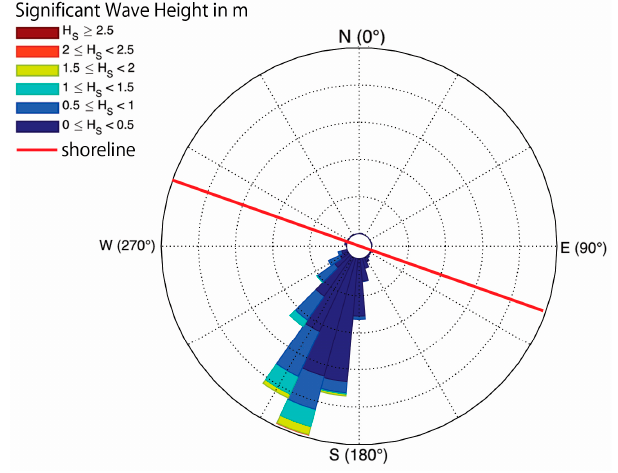
Figure 11. Wave rose and shoreline orientation.